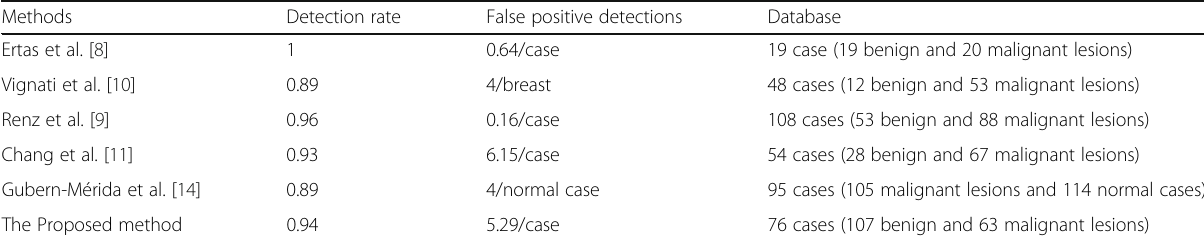
Table 2 Performance comparison between the proposed CAD system and available